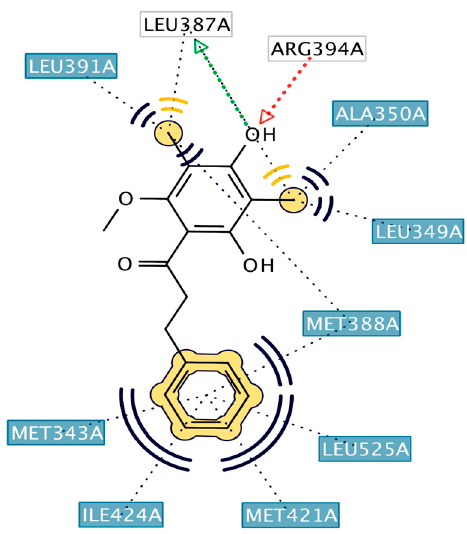
Figure 3. Best docked pose of ChalcEA with ER α . One hydrogen bond donor, one hydrogen acceptor and three hydrophobic (pi-alkyl) interactions are represented with green, red, and black, colored dashed lines, respectively. This interaction was visualized by LigandScout 4.1.